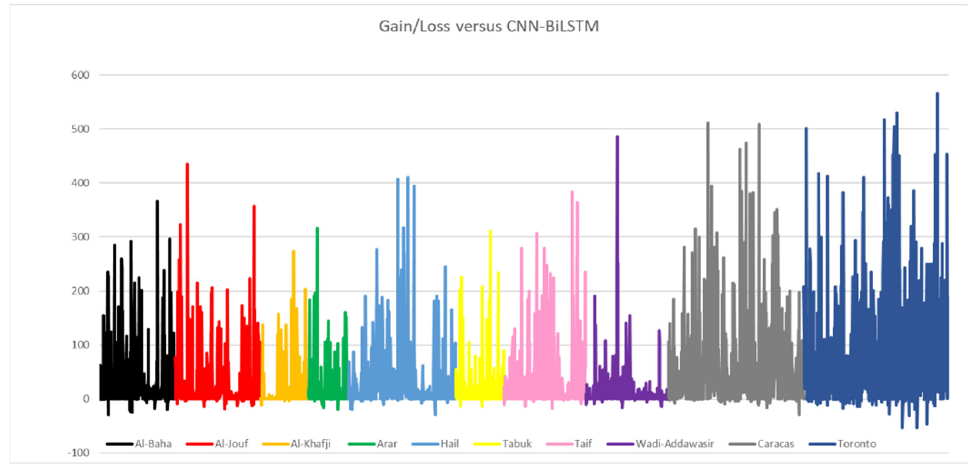
Figure 38. Gain/loss of SENERGY versus CNN-BiLSTM.